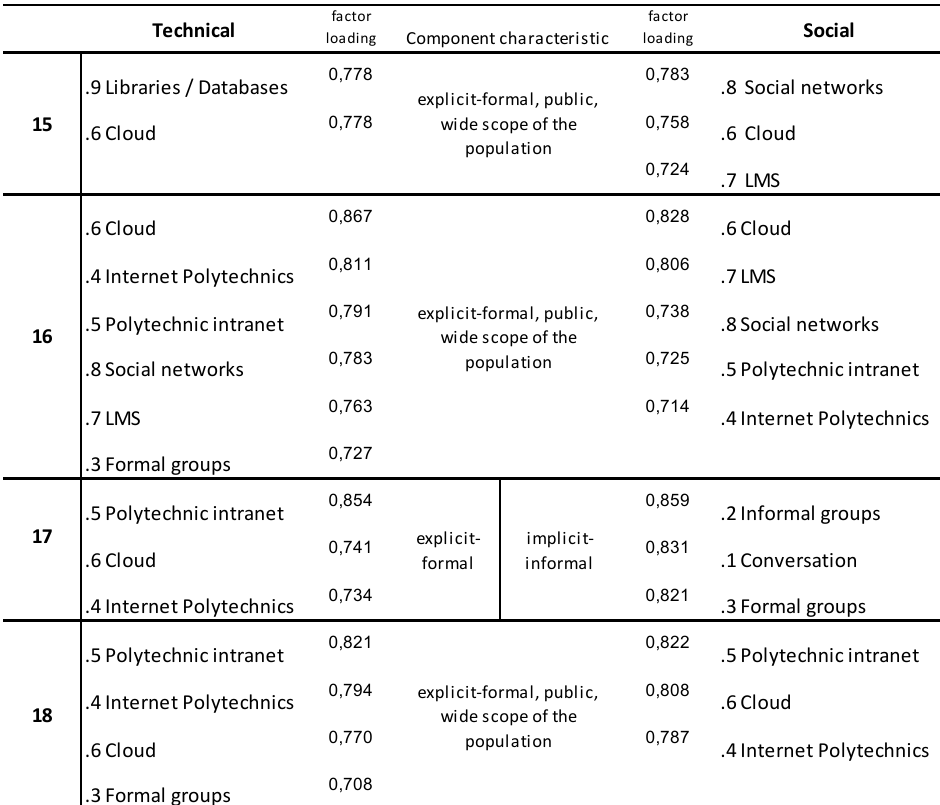
Figure 9. Areas and activities referred to by Factor one.